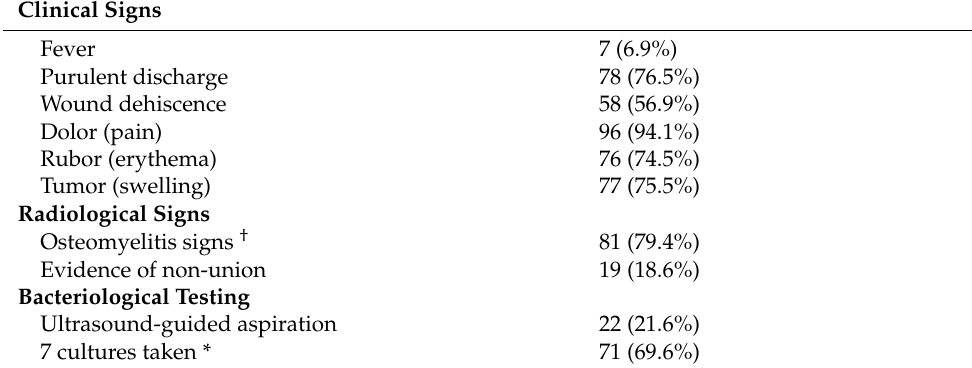
Table 3. Parameters of infection present in FRI patients.